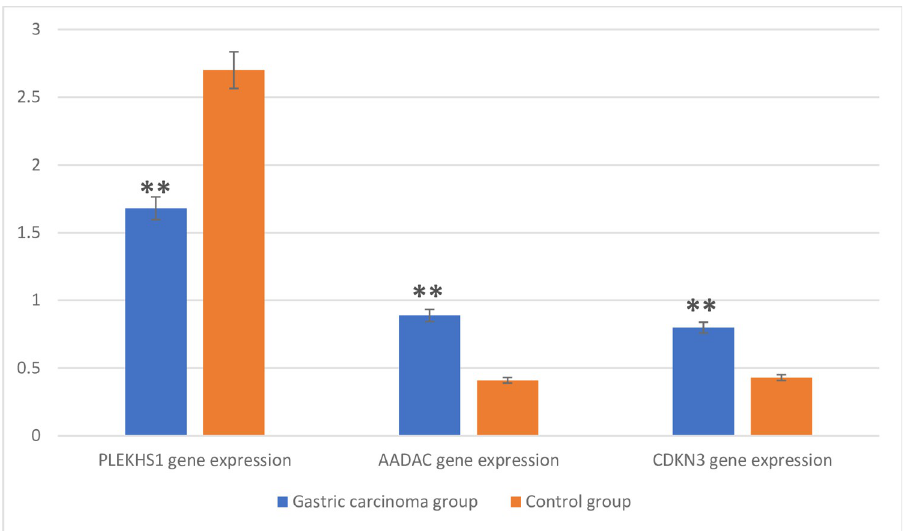
Fig 1. Comparison of PLEKHS1, AADAC, CDKN3 gene expressions between the studied groups. High significant elevations in AADAC gene expression and CDKN3 gene expression in the gastric carcinoma group compared to the control group while PLEKHS1 gene expression showed a high significant decrease in the gastric carcinoma group compared to the control group. �� : statistically high significant differences (P < 0.001) compared to the corresponding values in control